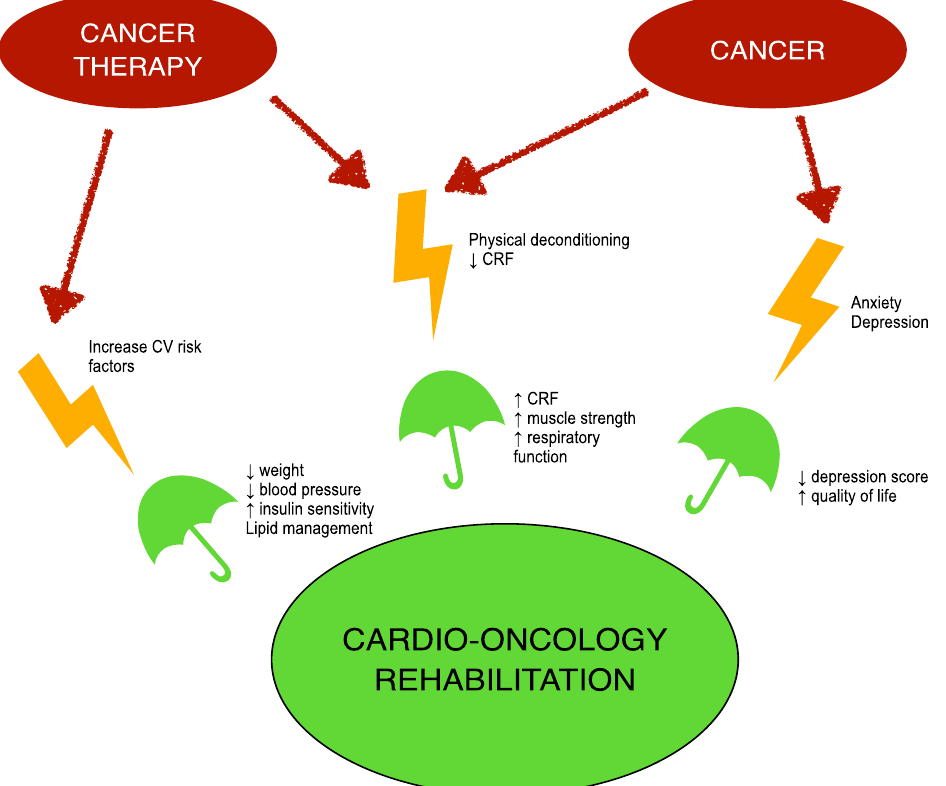
Figure 1. Mechanisms of CORE in counteracting side effects of cancer and its therapy. CRF: cardiores- piratory fitness; CV: cardiovascular.